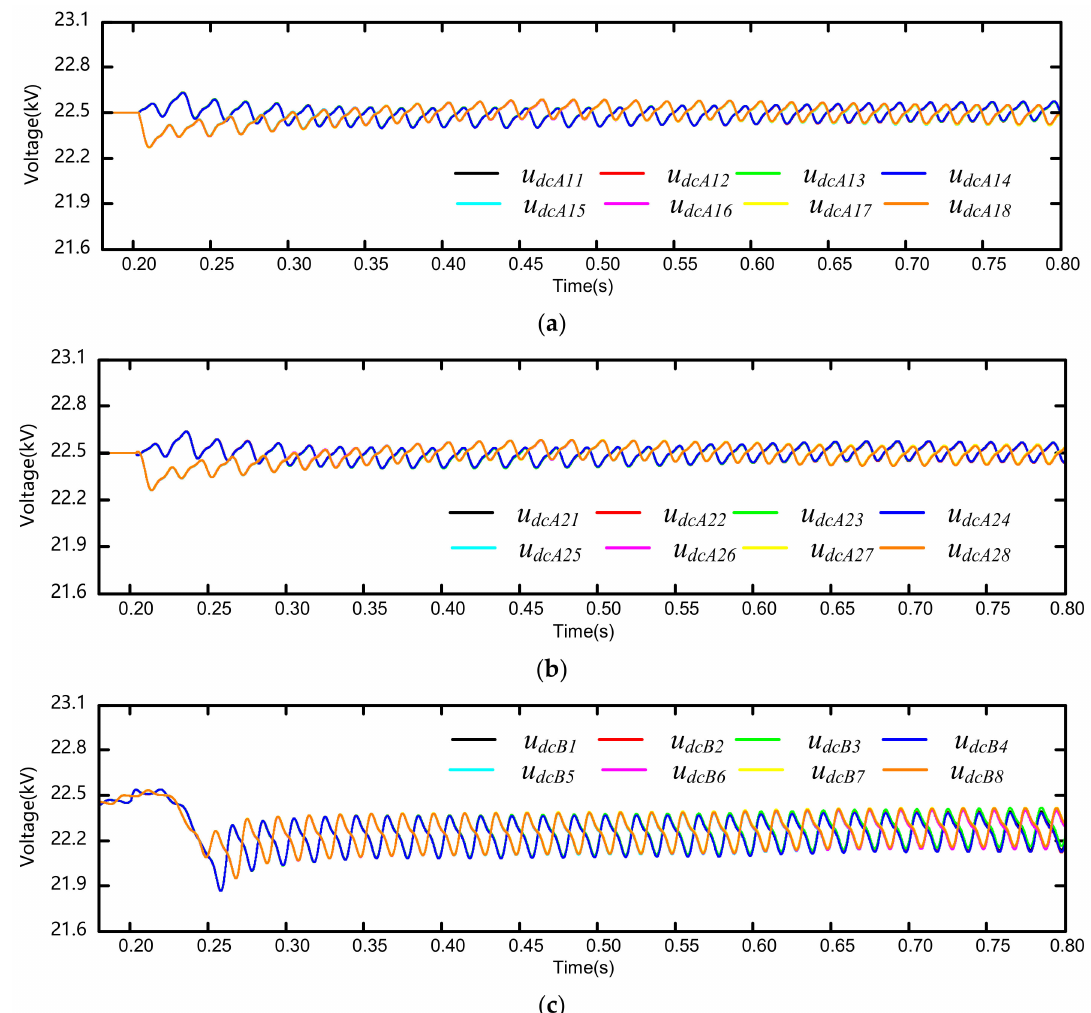
Figure 8. Voltages of sub-module capacitors: ( a ) VSC α 1 ; ( b ) VSC α 2 ; ( c ) VSC β .